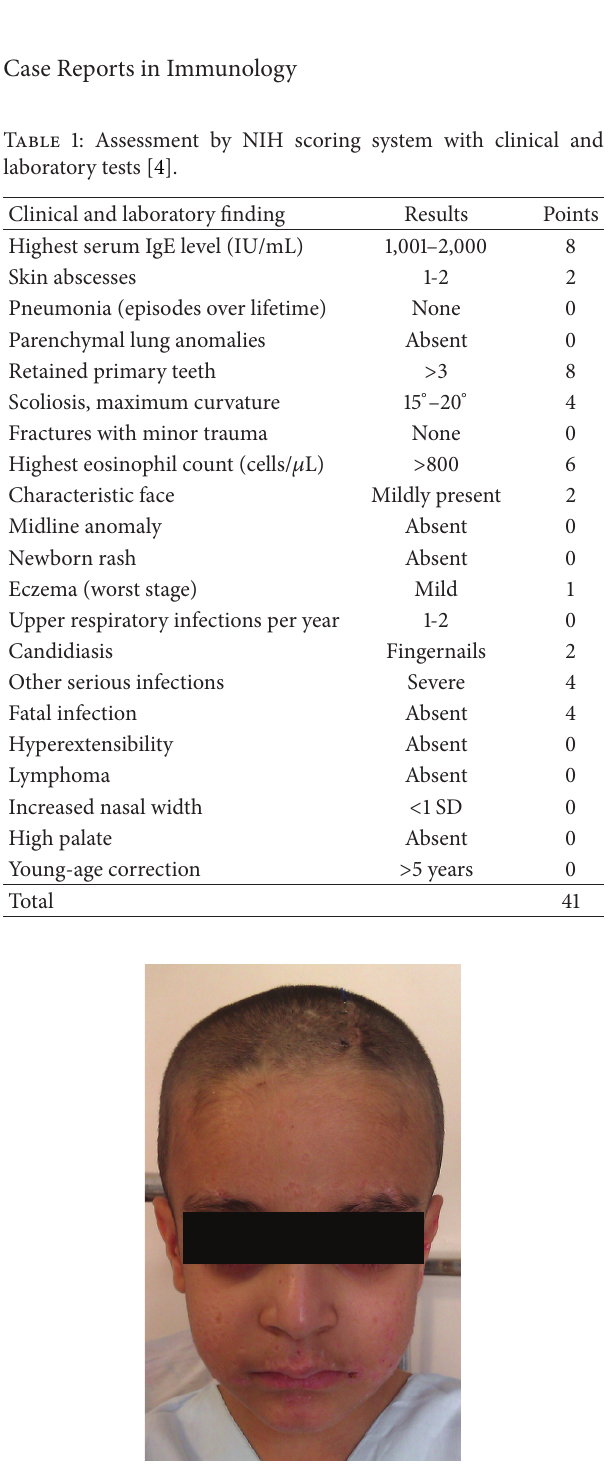
Figure3:Scarsinducedafterresolutionofkeratoacanthoma(8years old).